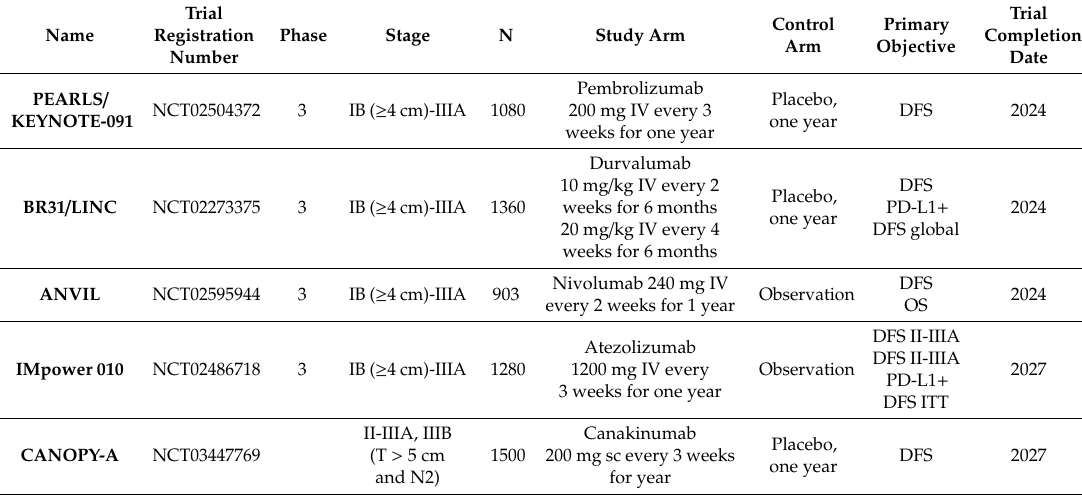
Table 2. Ongoing phase 3 clinical trials with adjuvant